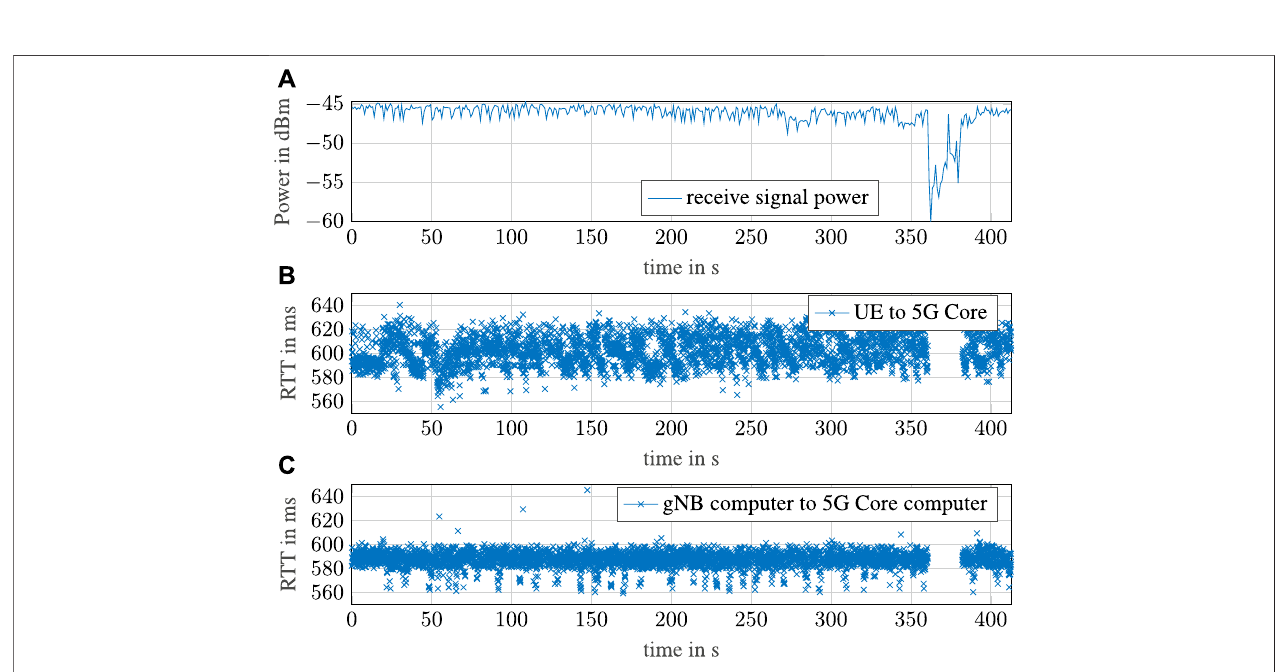
FIGURE 9 | Measurementresults showing the receivesignal power (satellite modem) in dBm (A) and the round trip times (RTTs) between UE/gNB and 5G Core in both directions (B,C) .